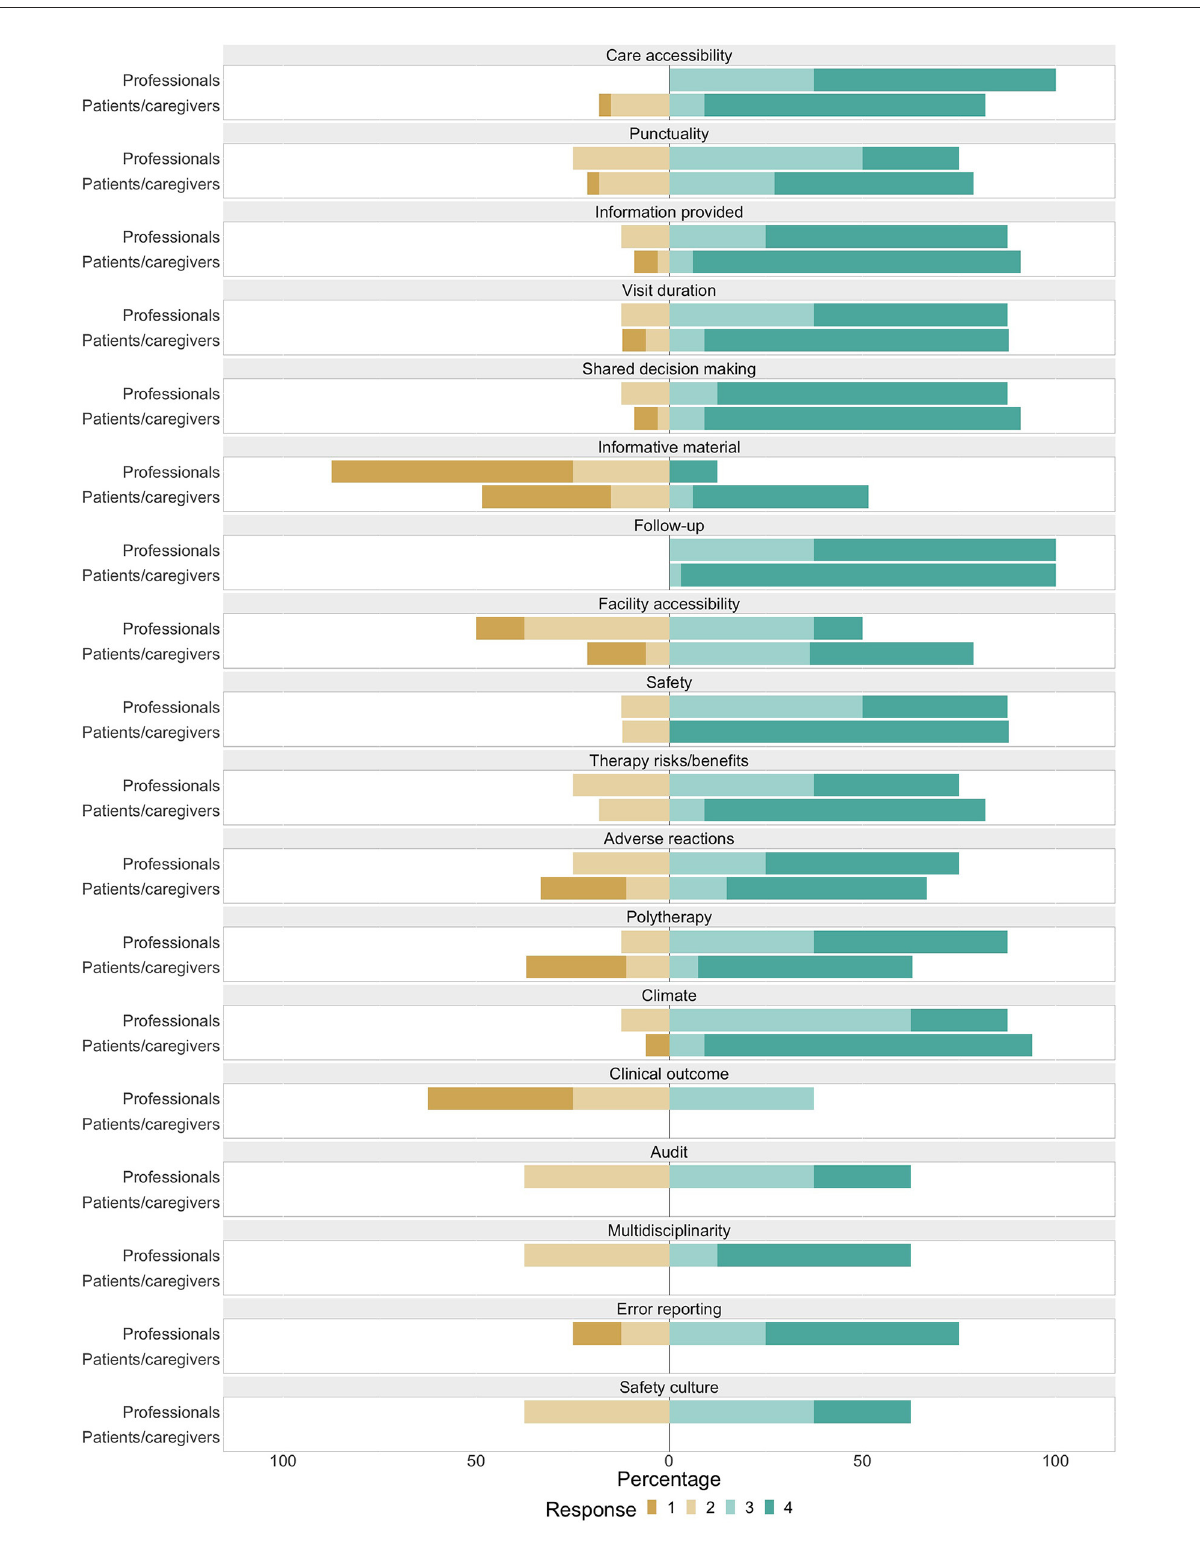
FIGURE2 Barplot showing distribution of Likert items’ responses among various scores, classified by group of raters. Scores 1, 2, 3, and 4, respectively correspond to responses: no, a little, rather much, very